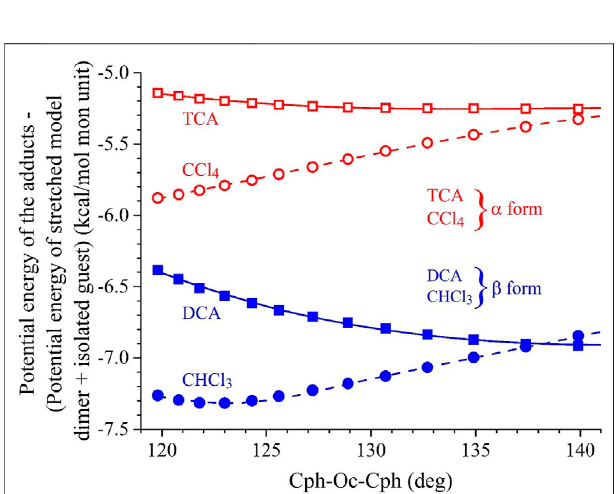
FIGURE 4 | Values of the potential energy gained by the stretched model dimerofPPOinthepresenceof α -and β -formsguestinducermolecules( Δ E )asa function of the value of the valence angle at the central Oc atom Cph-Oc-Cph ( τ ) de fi ned in Figure 3B . For each value of τ , the energy gain ( Δ E ) is calculated as the difference between the minimized potential energy of the adduct (guest + stretched model dimer) E a-st with stretched model dimer and the sum of the potential energy of the isolated guest ( E g ) and of the isolated model dimer with τ deformed to the same value of the adduct ( E d-st ), that is, Δ E = E a-st − ( E g + E d-st ). (cid:129) GuestmoleculessuchasDCA( ■ )andchloroform( )areconsideredasexamples of β -form guest inducers, whereas TCA ( □ ) and carbon tetrachloride ( ○ ) are considered as examples of α -form guest inducers. Minima approached starting from different initial con fi gurations that correspond, for each τ , tovalues of Δ E that are either coincident or slightly